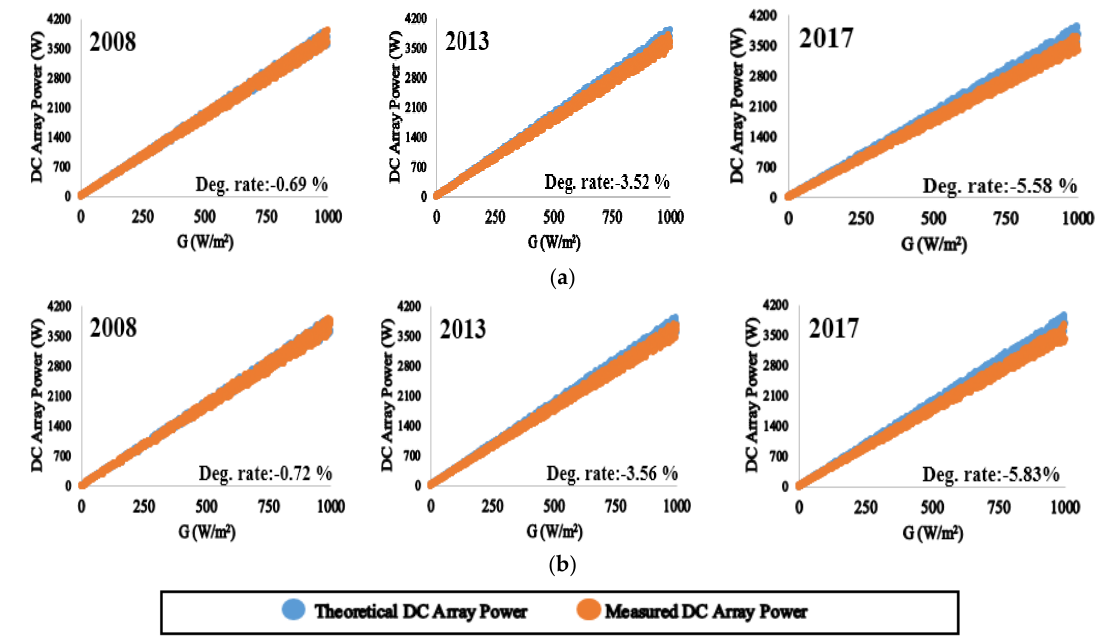
Figure 5. Cumulative degradation rates for PV systems F and G in 2008, 2013, and 2017: ( a ) PV site F—Dublin; ( b ) PV site G—Sligo.